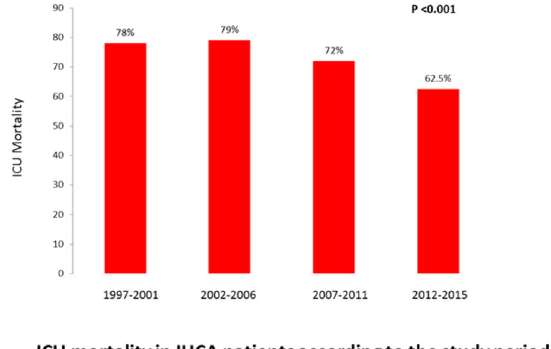
Fig. 1 Kaplan‑Meier 30‑day survival plot of patients with sepsis stratified according to the evolution of acute kidney injury after admission to the intensive care unit Fig. 1 In‑ICU mortality in IHCA patients according to time